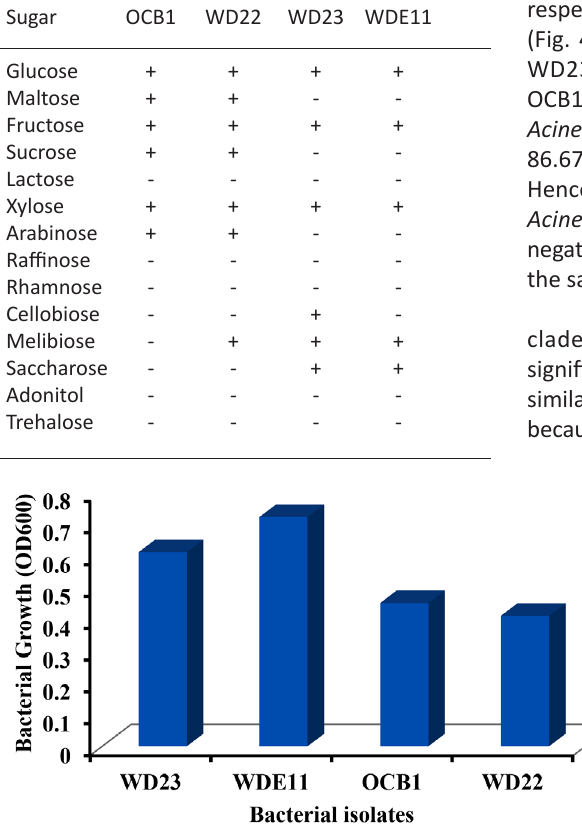
Fig. 5. Growth of isolates in sea water supplemented with PCO, glucose and yeast extract